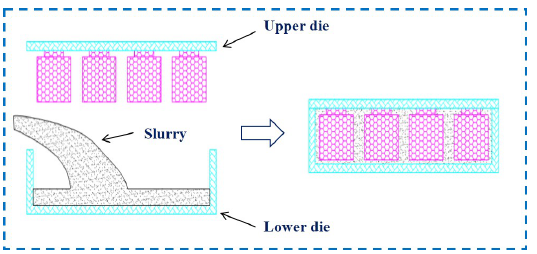
Figure 1. Flowchart of the forming process.